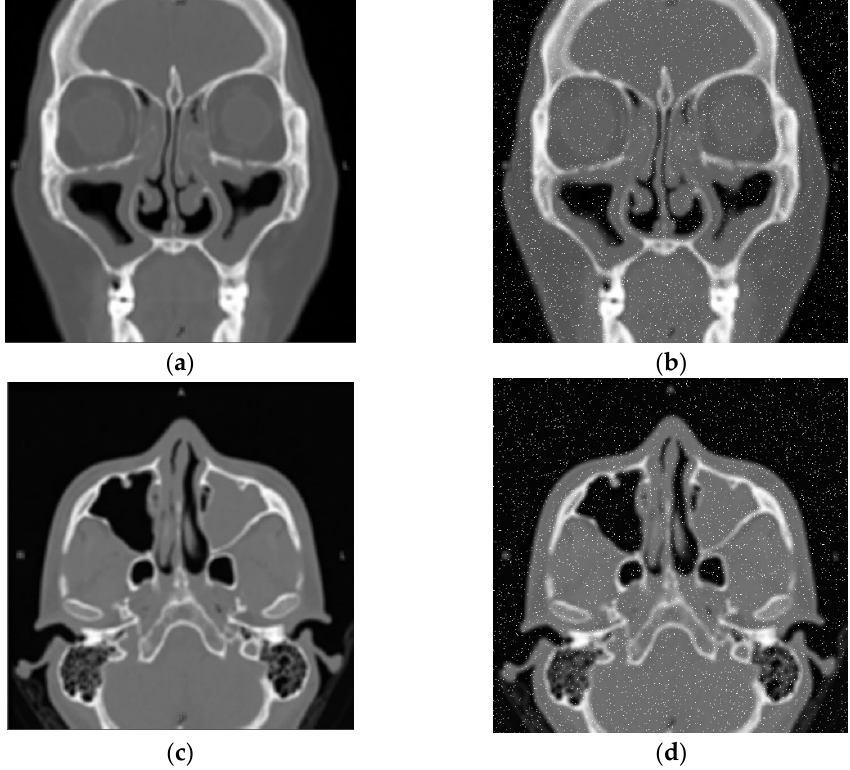
Figure 12. Resulting images after Gaussian noise. ( a ) Gaussian blurred image; ( b ) Gaussian noise image; ( c ) Gaussian blurred image; ( d ) Gaussian noise image.